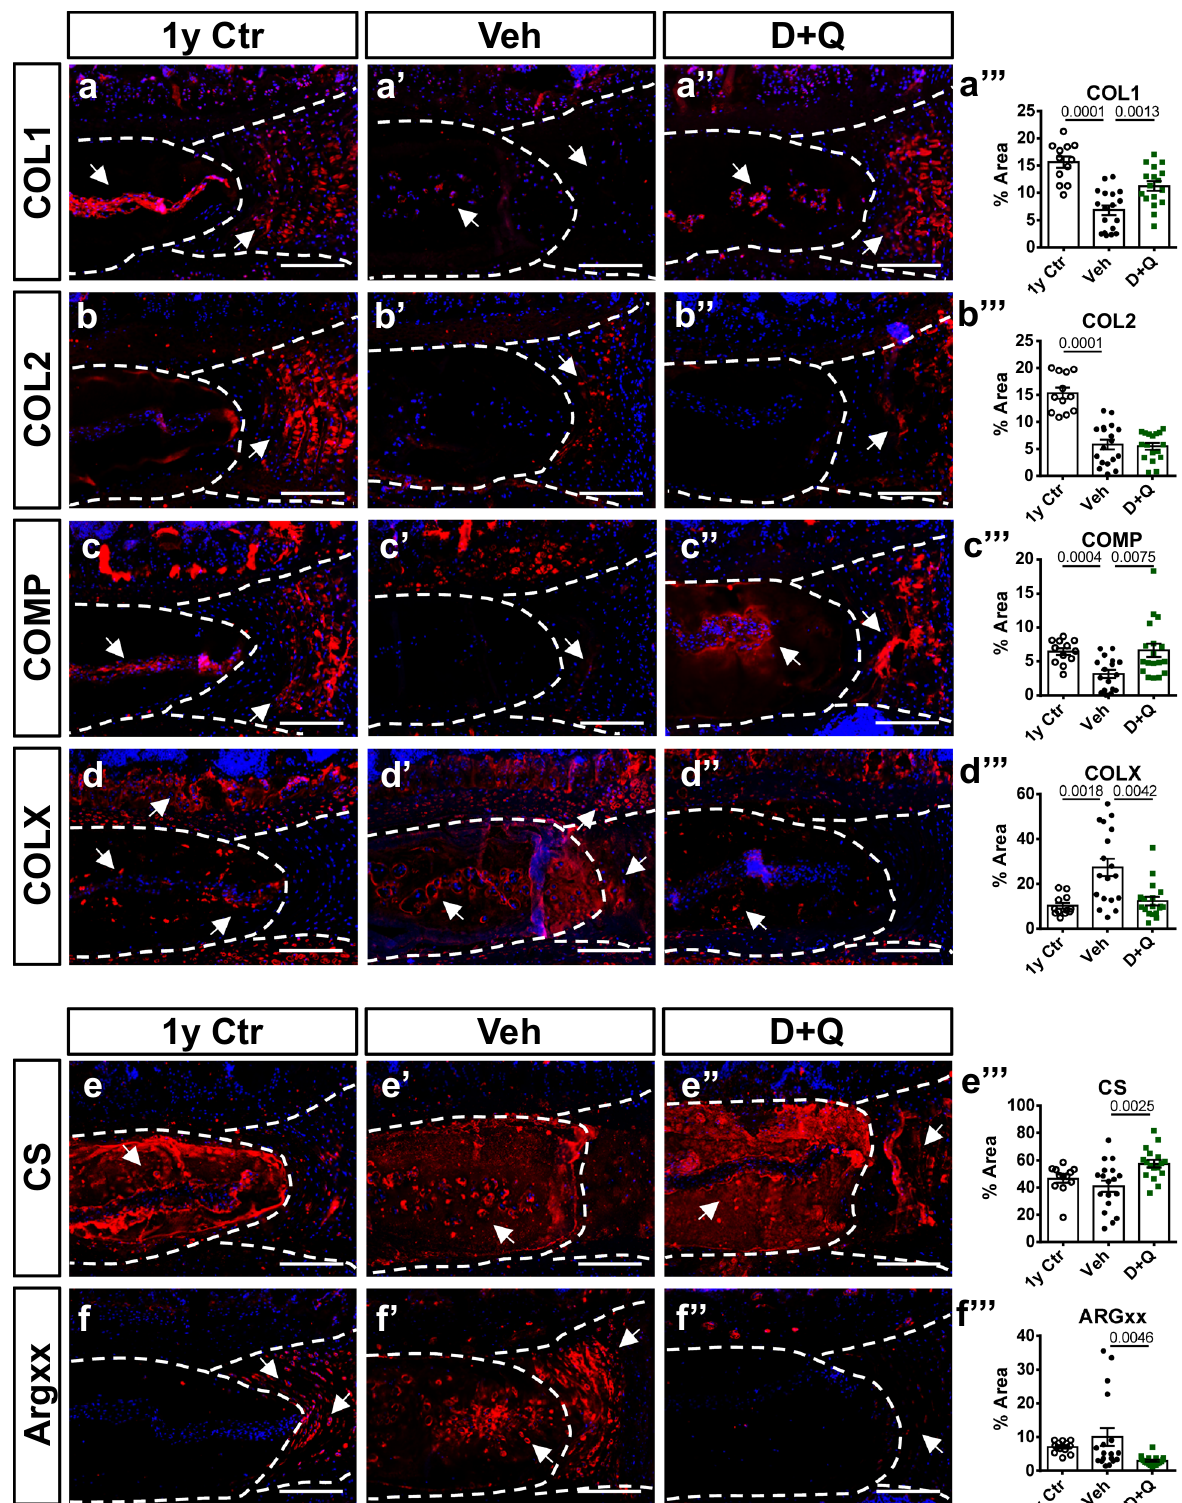
Fig. 3 D + Q treatment preserved healthy extracellular matrix composition with a decrease in Aggrecan degradation during aging. a – f ”’ Staining and abundance in the disc compartment of essential extracellular matrix proteins in 1 y Ctr, 14 – 23 M Veh, and 14 – 23 M D + Q groups: Collagen I, Collagen II, COMP, Collagen X, Chondroitin sulfate, and ARGXX neoepitope. Two-tailed ANOVA or Kruskal – Wallis tests were used as appropriate; n = 6